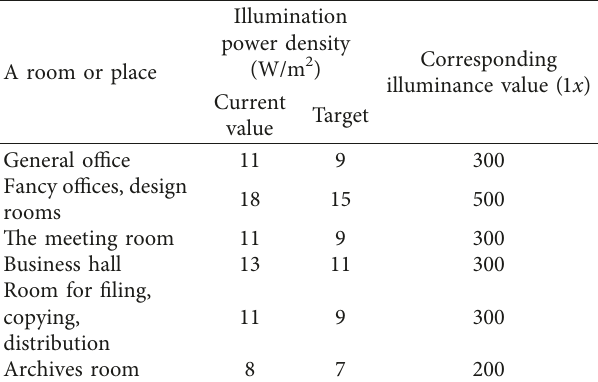
Table 1: Energy-saving requirements in the code for architectural lighting